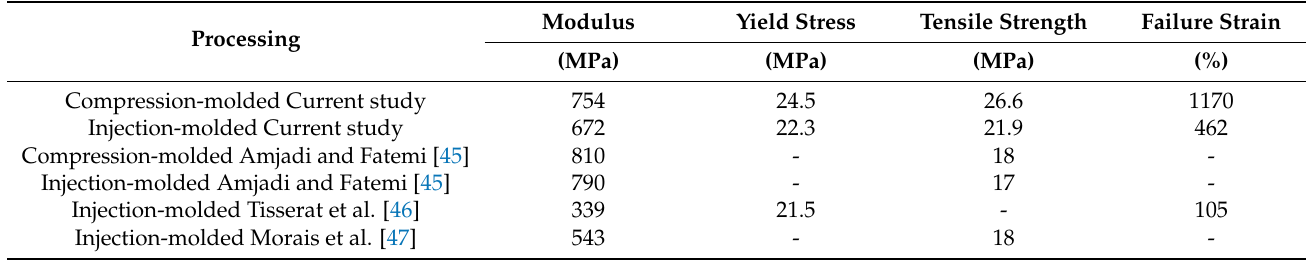
Table 2. Compression-molded and injection-molded sample mechanical